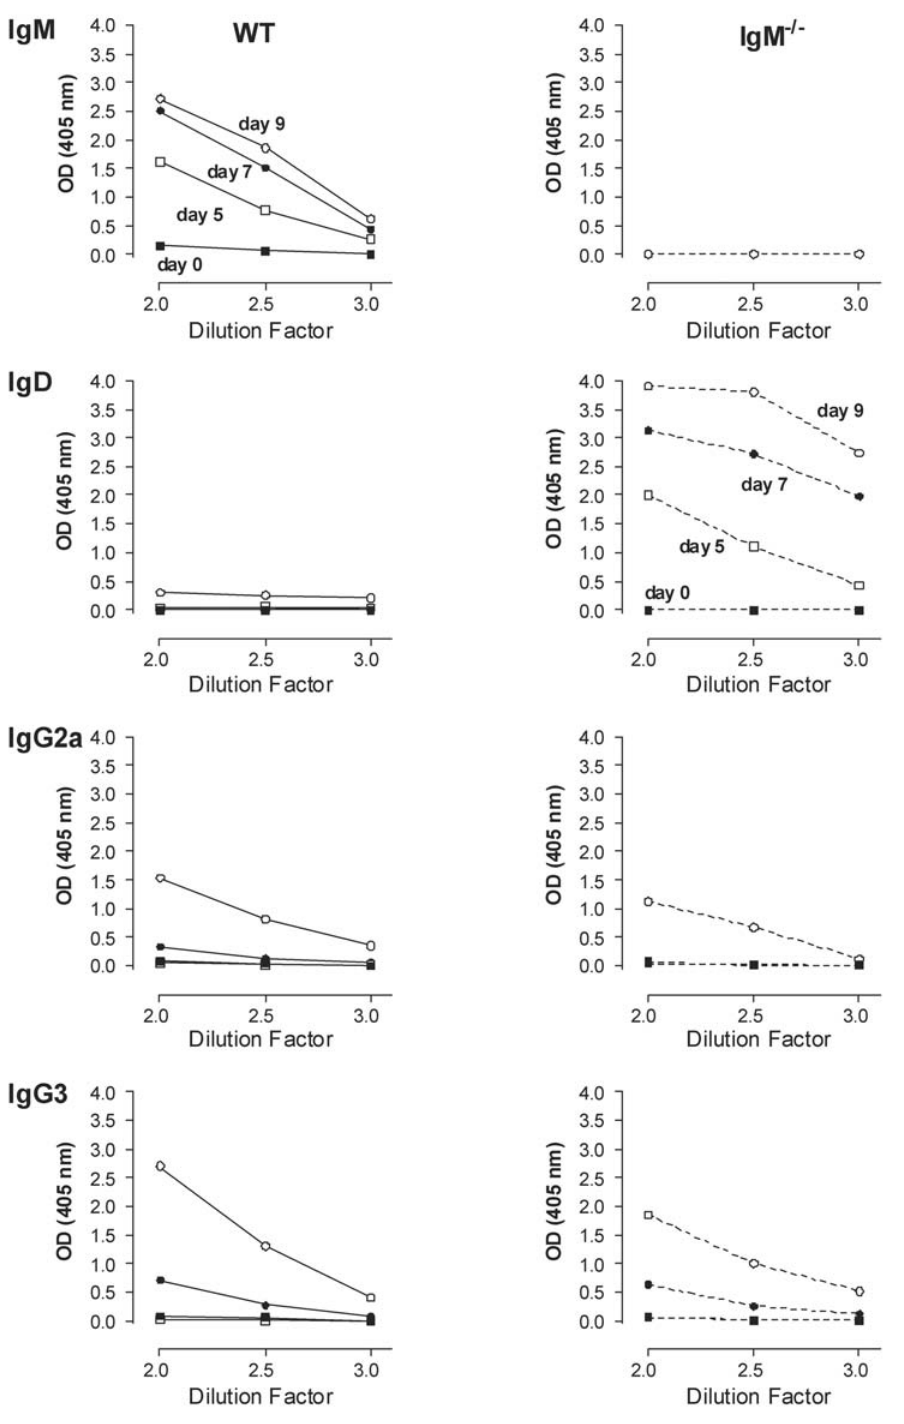
Figure 3. Trypanosome infected IgM 2 / 2 mice produce compensatory IgD titers. Sera were collected from T. brucei AnTat 1.1E infected WT and IgM 2 / 2 BALB/c mice, and were analyzed as serial dilutions (log 10) in a solid phase VSG coated ELISA, using isotype-specific antibodies for detection. Sera were collected throughout the first peak and clearance phase from 5 individual mice. Values are presented as means.